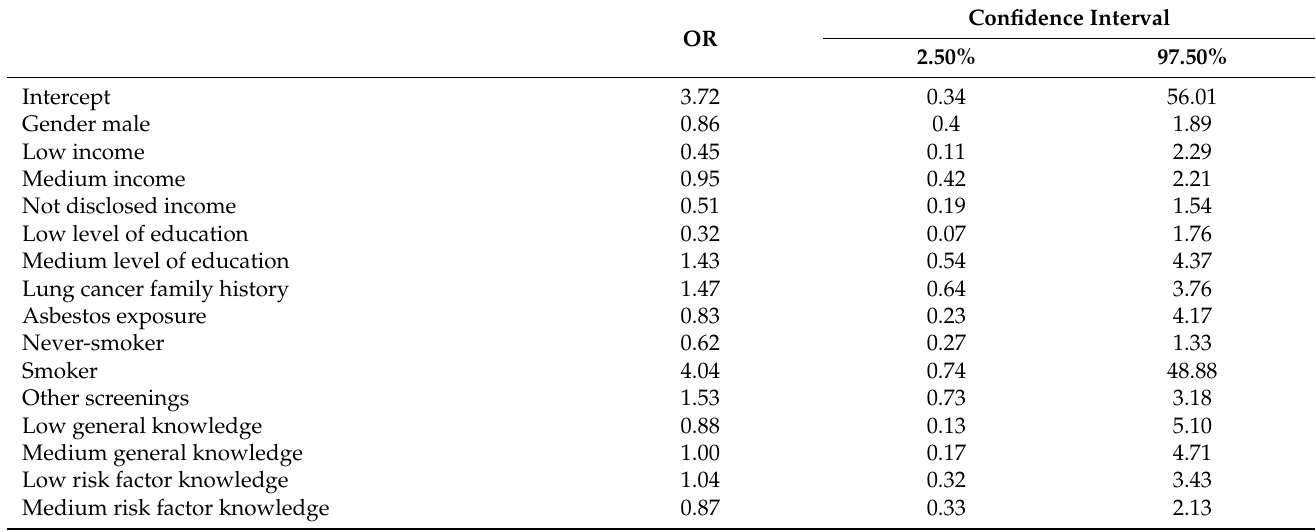
Table 4. Odds ratio of acceptability of implementing a lung cancer screening program in Flanders with a 95% confidence interval for all variables and their subcategories in the dataset with complete cases. This table shows the variables included in the study for odds of acceptability. OR signifies the odds ratio, while 2.50% and 97.50% refer to the limits conforming to the 95% confidence interval. The intercept is the odds of acceptability of implementing an LCS program independent of covariates. * Significant odds